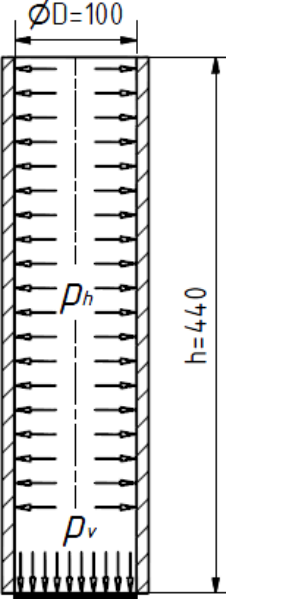
Figure 4: Image of pressures acting inside the storage